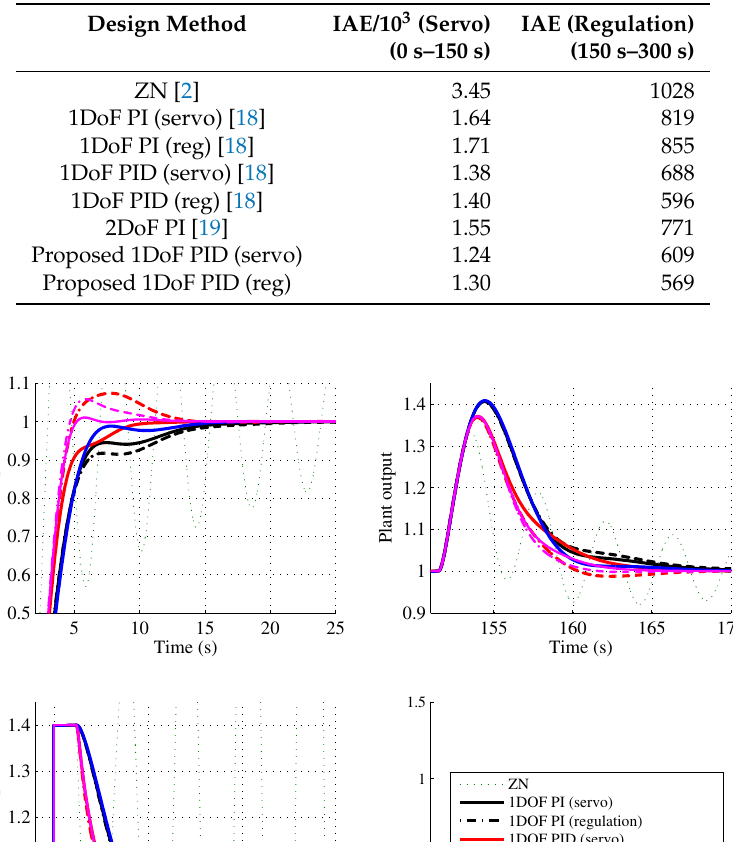
Table 10. Integral of absolute error (IAE) performance.